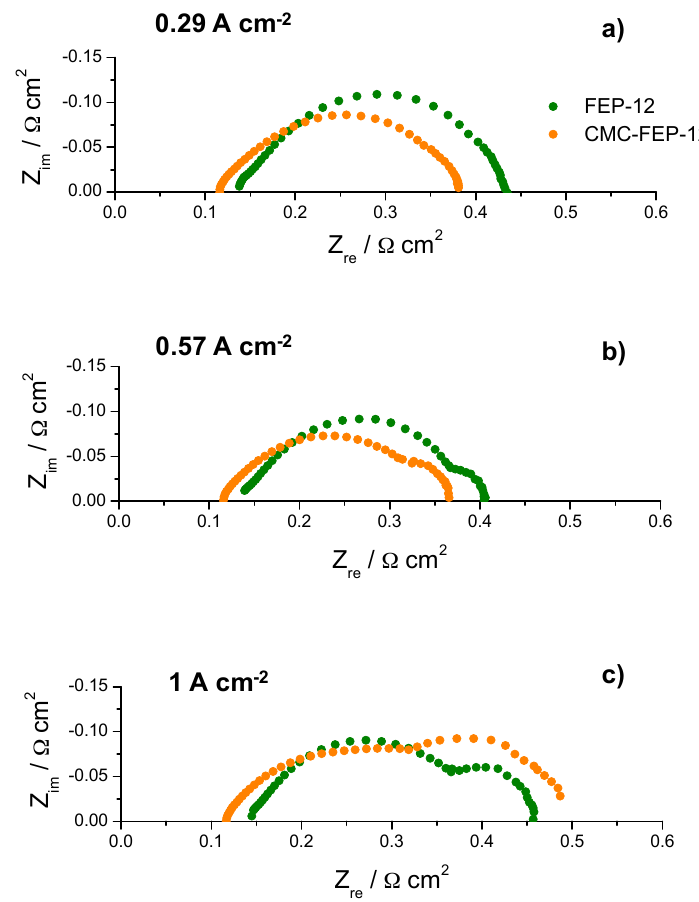
Figure 10. Example of typical impedance spectra obtained (at 60 °C and RH (A-C): 80–60%) for fuel cells assembled with FEP-12 and CMC-FEP-12 samples at: low current density ( a ); medium current density ( b ); and high current density ( c ).